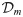
Signatures for non-Poisson arrival.The quantities Dm, Dp and Dmp are plotted for the model shown in Fig 2a as a function of off rate β. Analytic estimates are shown by lines whereas points correspond to the simulation results with parameters: α = 0.25, k
m = 2, ⟨m
b⟩ = 5, k
p = 0.5, μ
m = 1, μ
p = 0.01.